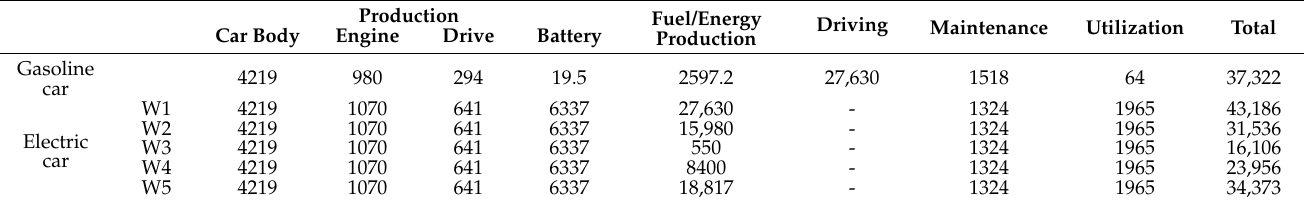
Table 5. List of emissions in kg-CO 2 for the entire life cycle of the vehicle (150,000 km, 10 years).